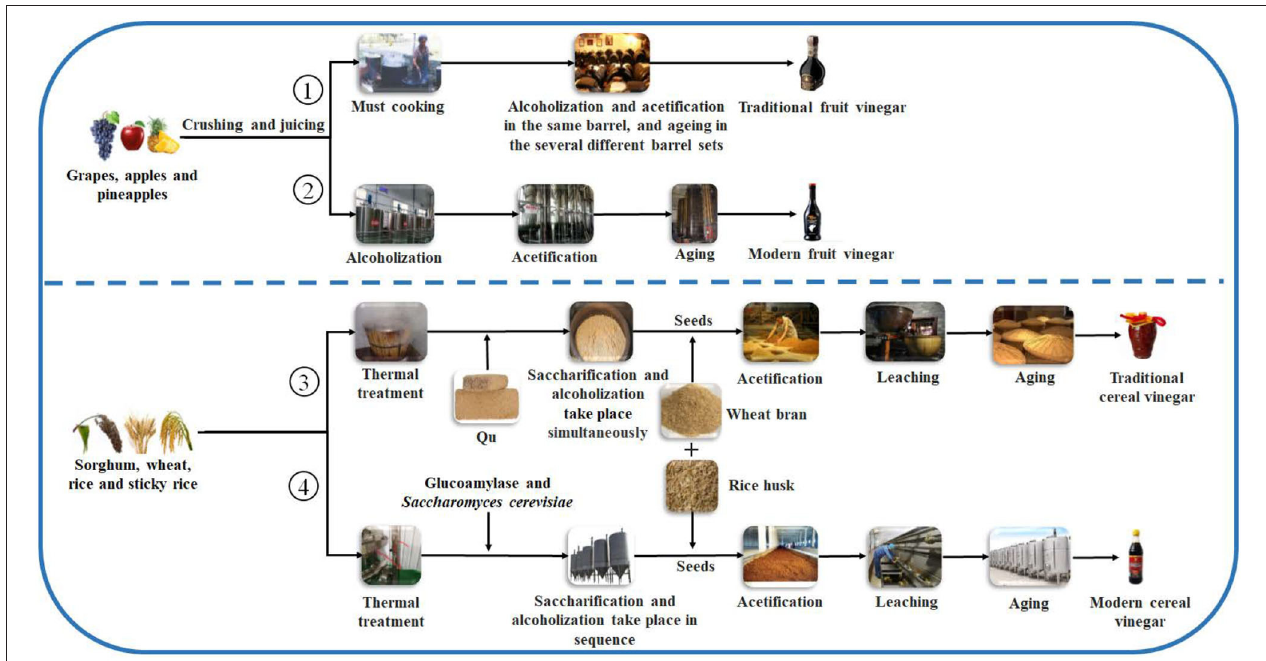
FIGURE 2 | General schematic diagrams of vinegar brewing. ‹ : Traditional fruit kinds of vinegar brewed by liquid-state fermentation; › : Modern fruit kinds of vinegar brewed by liquid state-fermentation; fi : Traditional cereal kinds of vinegar brewed by solid-state fermentation; fl : Modern cereal kinds of vinegar brewed by liquid- and solid-state